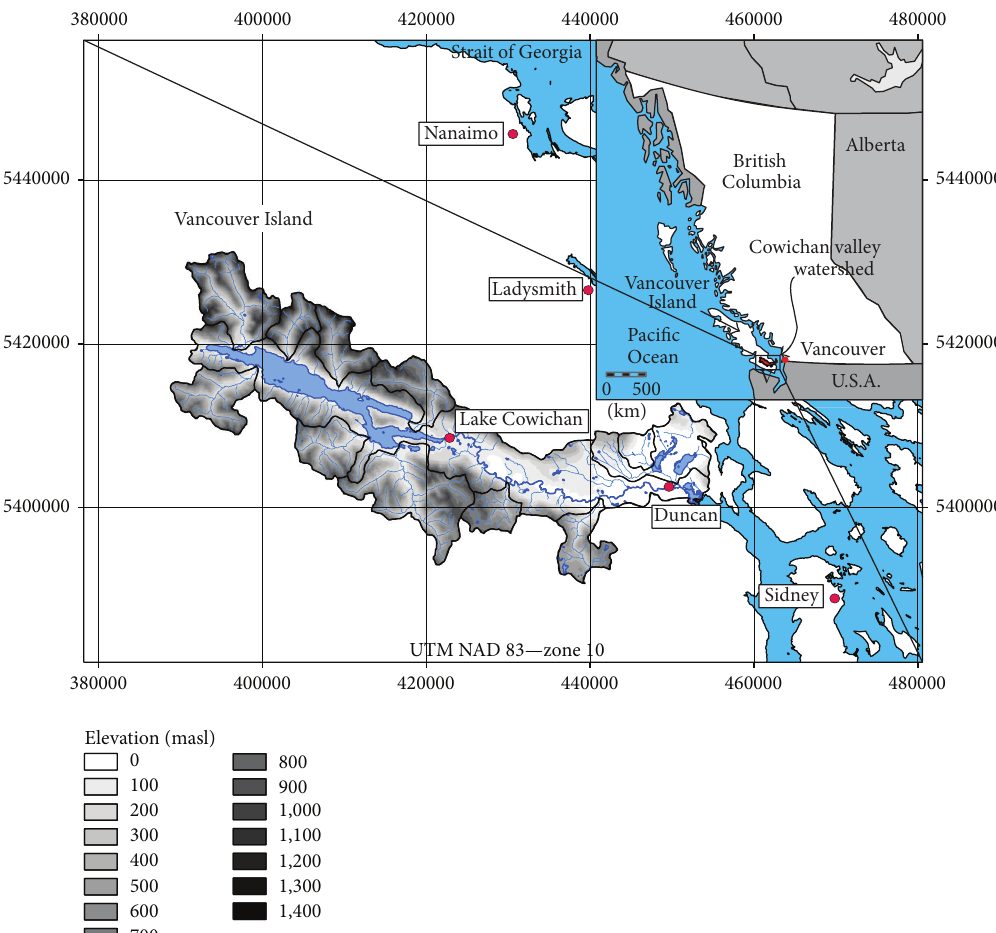
Figure 1: Location of the Cowichan Watershed, British Columbia,